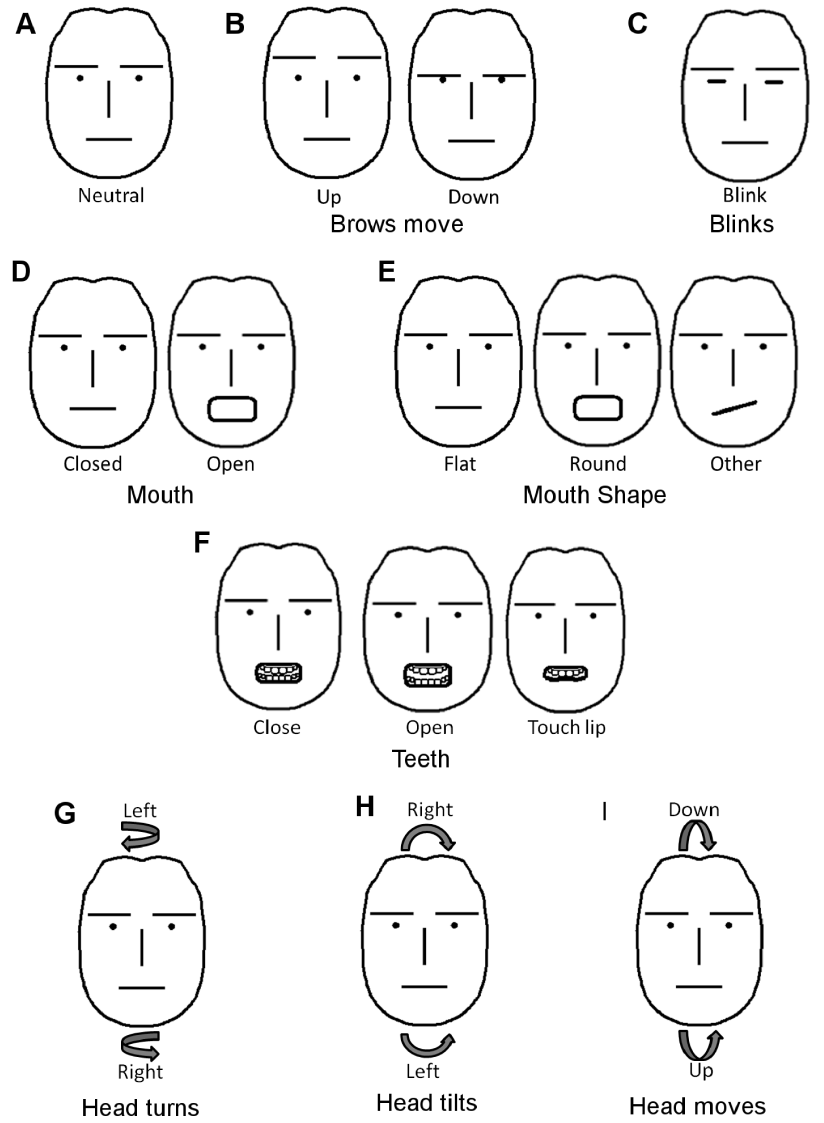
Figure 3. The configural and shape positions used to define each of the nonmanuals in sentences of ASL. In A we show a neutral face. A neutral face is defined as one without expression where all facial muscles are relaxed (except for the eyelids which are open). B We consider two configural positions for the eyebrows (up and down). C Blinks are marked by closing the eyelids. D The mouth can be open or closed. E We also annotate mouth shape where appropriate (flat, round and other). F When there is teeth showing, we consider three distinct positions – closed (top and bottom teeth touching), open (not touching), touching lips (where the top teeth are over the lower lip or the bottom teeth touch the upper lip). G – I We also consider the three possible rotations of the head – turns, tilts and forward/backward